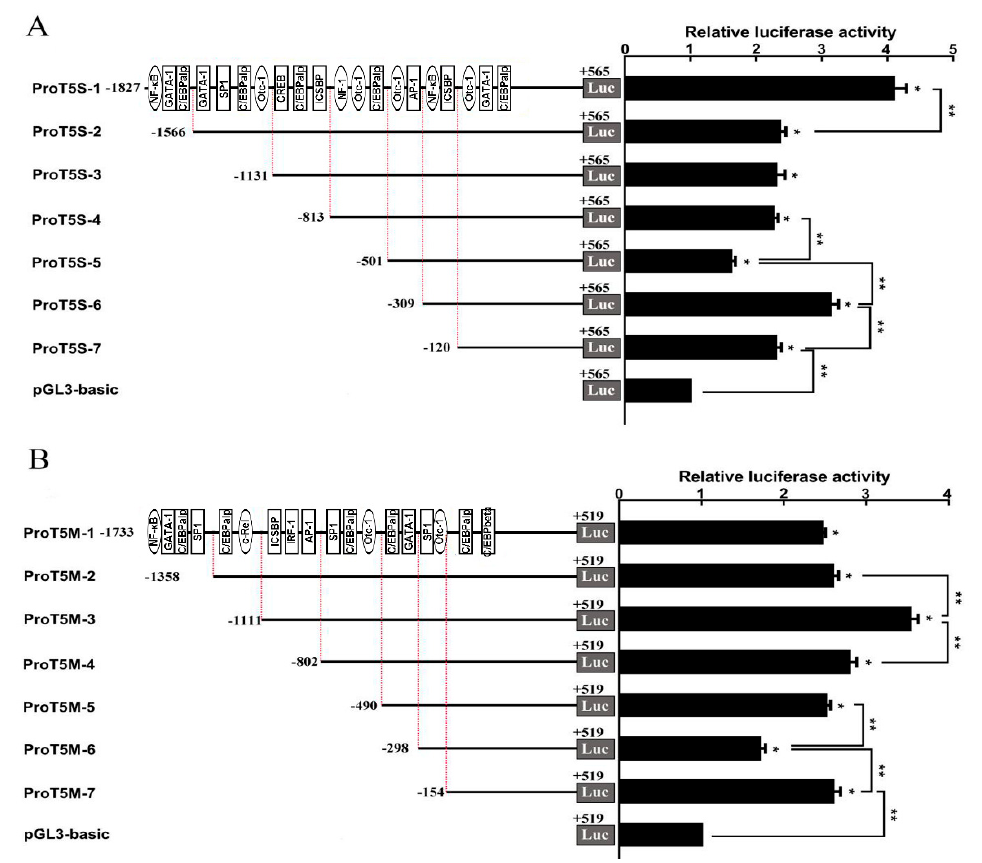
Figure 6. Promoter activity analysis of ToTLR5M ( A ) and ToTLR5S ( B ). ( A ) Seven recombinant plasmids, denoted as ProT5M-1 ( − 1827 to + 565), ProT5M-2 ( − 1566 to + 565), ProT5M-3 ( − 1131 to + 565), ProT5M-4 ( − 813 to + 565), ProT5M-5 ( − 501 to + 565), ProT5M-6 ( − 309 to + 565), and ProT5M-7 ( − 120 to + 565) were constructed and transfected into Trachinotus ovatus snout tissue (GPS) cells. ( B ) Seven recombinant plasmids, denoted ProT5S-1 ( − 1733 to + 519), ProT5S-2 ( − 1358 to + 519), ProT5S-3 ( − 1111 to + 519), ProT5S-4 ( − 802 to + 519), ProT5S-5 ( − 490 to + 519), ProT5S-6 ( − 298 to + 519), and ProT5S-7 ( − 154 to + 519) were constructed and transfected into GPS cells. Different color boxes indicate binding sites located in different truncation regions. All data are expressed as mean ± SE in the picture ( n = 5). * indicates significant differences ( p < 0.05). ** indicates extremely significant differences ( p < 0.01).